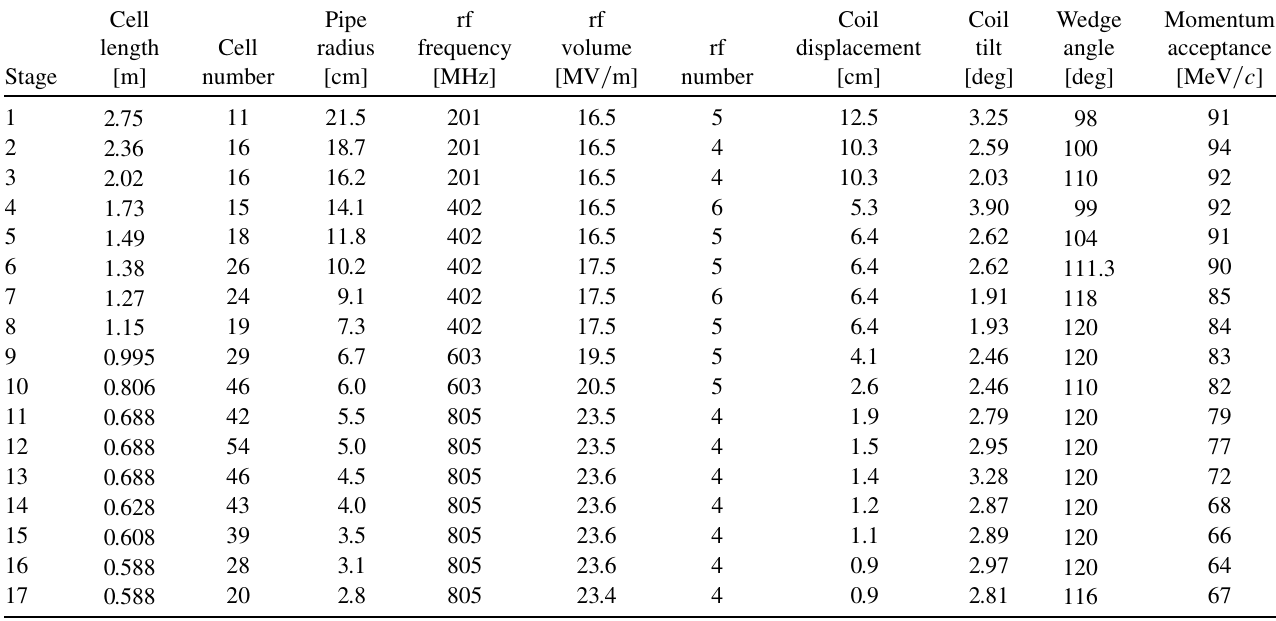
TABLE I. Main lattice parameters of a tapered ziggurat shaped helical